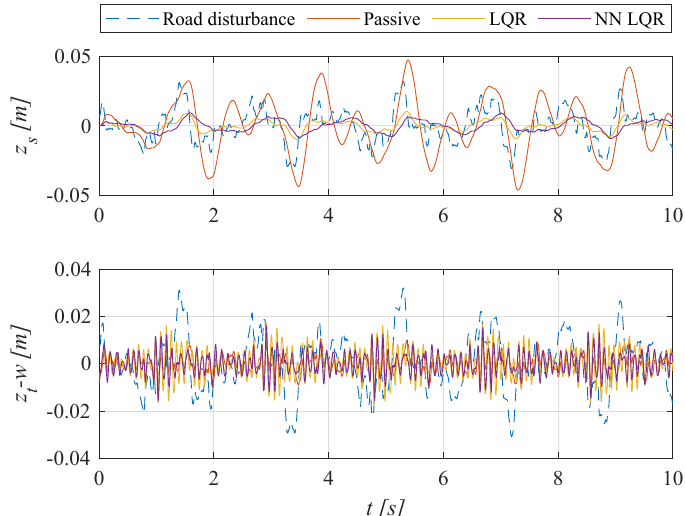
Figure 8. Time courses of sprung mass displacement and tire deflection (ISO C-D, 60 km/h).